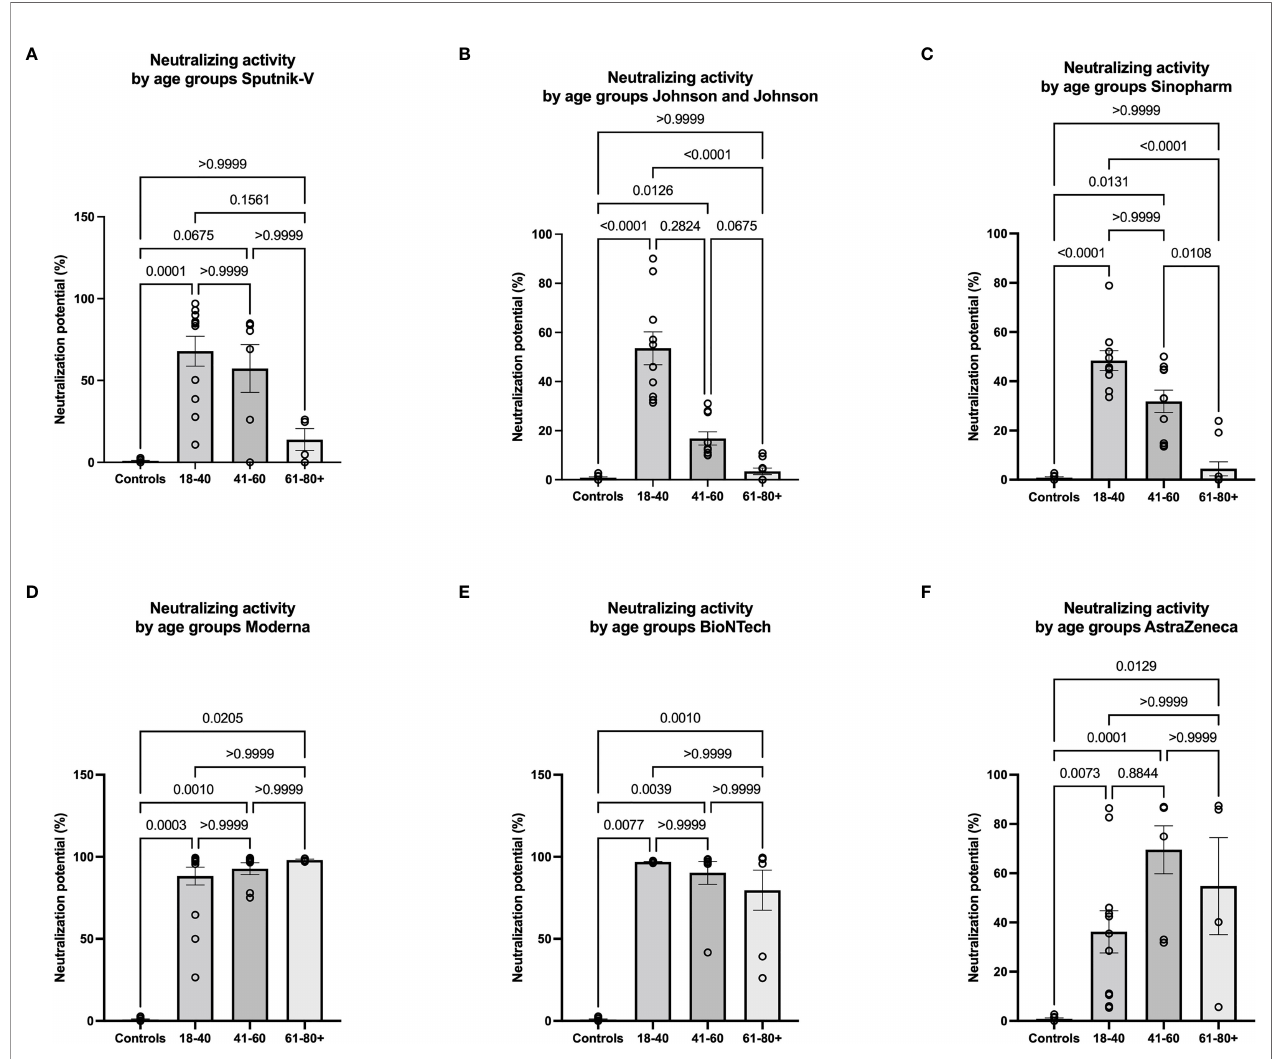
FIGURE 5 | Low neutralizing antibody response in older vaccinees of Sputnik-V, Johnson and Johnson, and Sinopharm groups. Graphs represent the relative expression of neutralizing antibodies observed using sera from Sputnik-V (A) , Johnson and Johnson (B) , Sinopharm (C) , Moderna (D) , BioNTech (E) , and AstraZeneca (F) vaccinees in 3 different age categories: 18-40, 41-60, and 61-80+ years old. Each symbol represents individual donors. Indicated p values were calculated using Kruskal-Wallis ‘ test followed by Dunn ’ s comparison post hoc to compare all groups. Bars represent the mean percentages of relative neutralizing antibody expression ± SEM. Signi fi cance is accepted if p